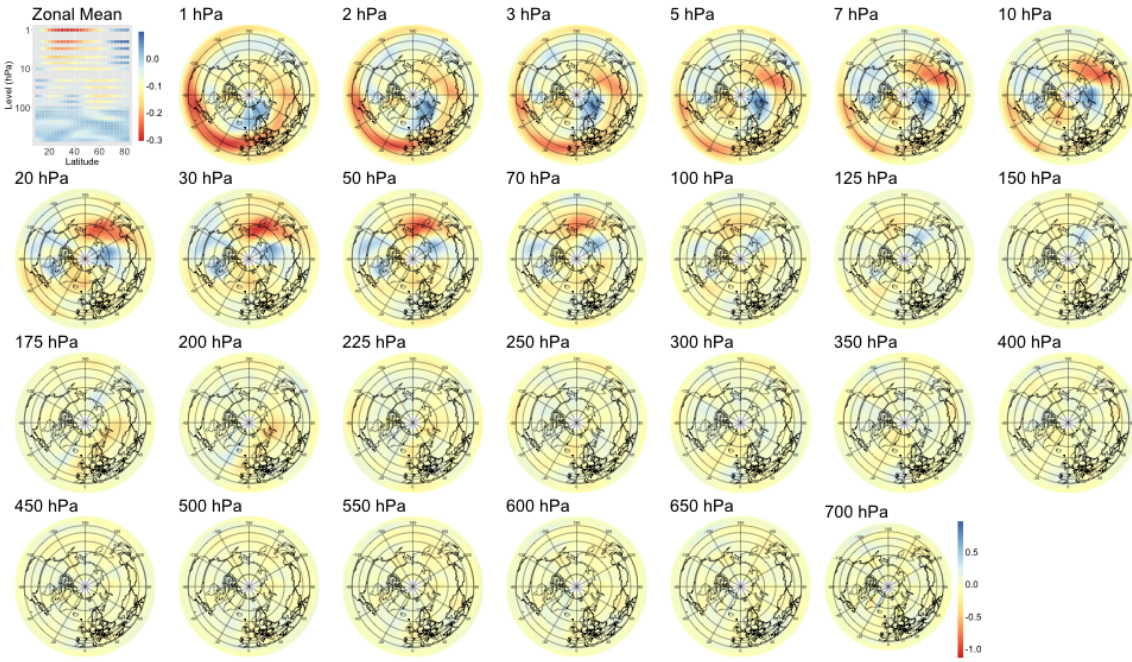
Figure B13. Patterns of heat flux maximizing correlation with the SSW index at a lead time of 30d. The upper-left plot displays the patterns’ zonal averages.